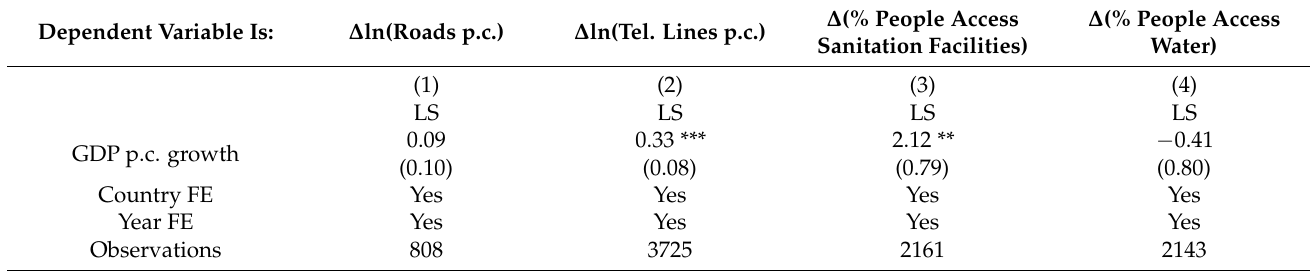
Table 2. GDP growth and infrastructure: (least squares